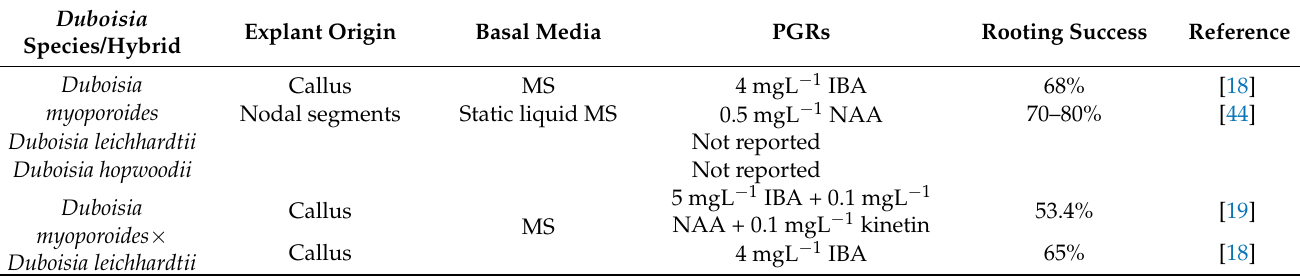
Table 4. Summary of PGRs used in shoot induction in Duboisia